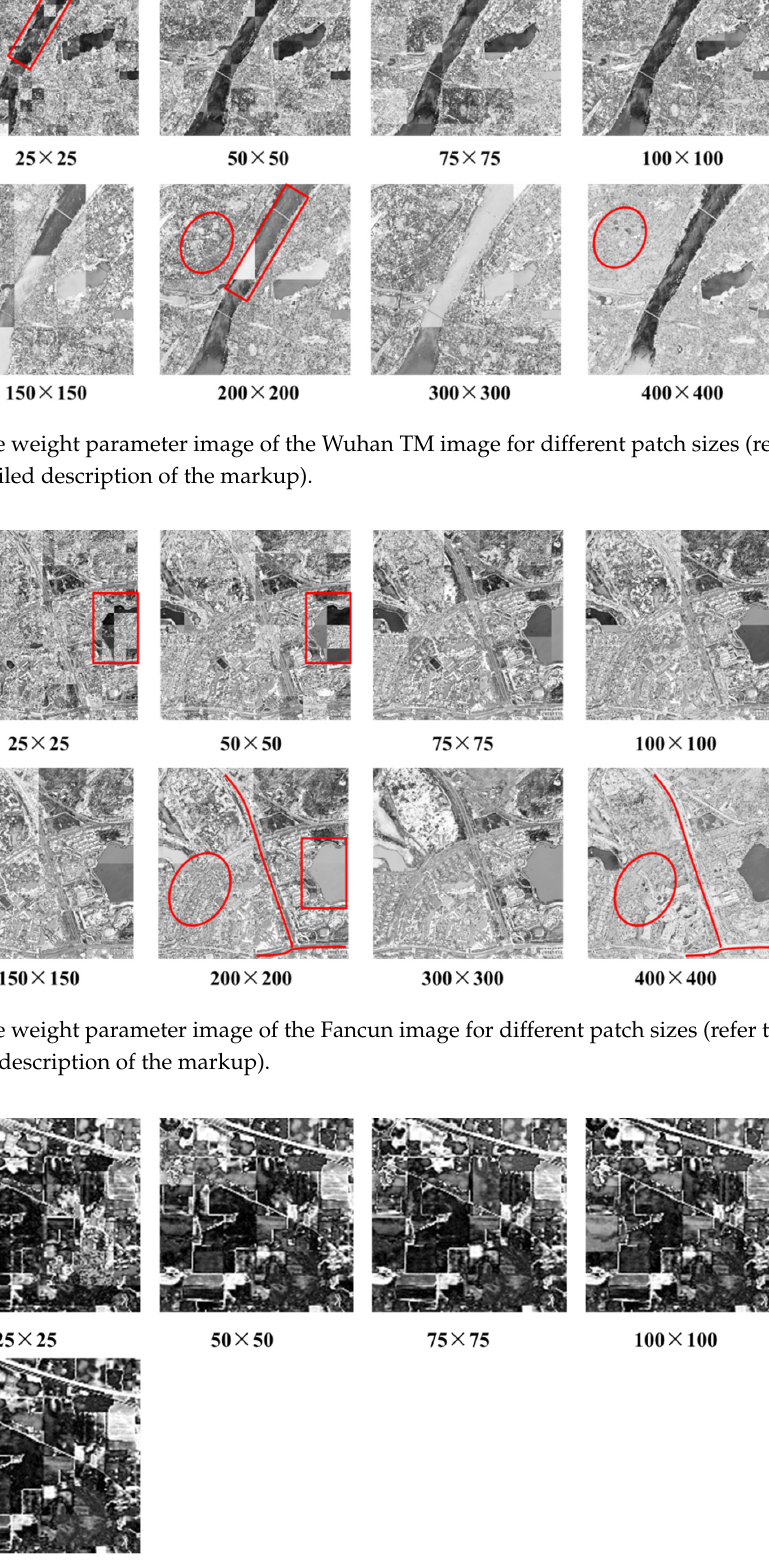
Figure 13. The weight parameter image of the Indian Pine image for different patch sizes.